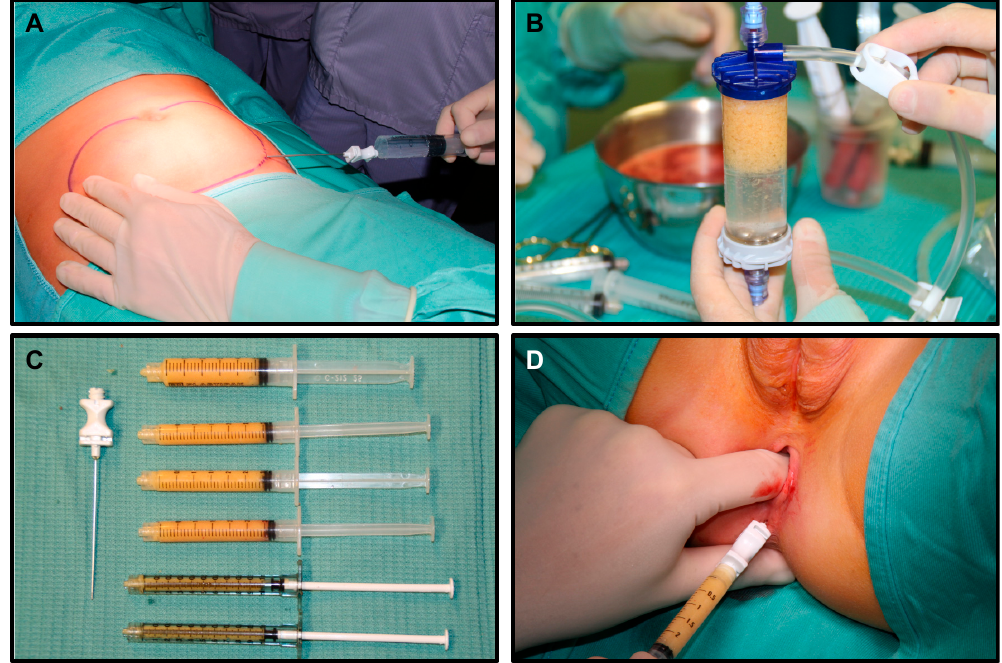
Figure 1. Lipofilling procedure: A . Lipoaspiration, B . Adipose tissue processing technique, C . Adipose tissue ready for injection; D . intersphincteric adipose tissue injection.